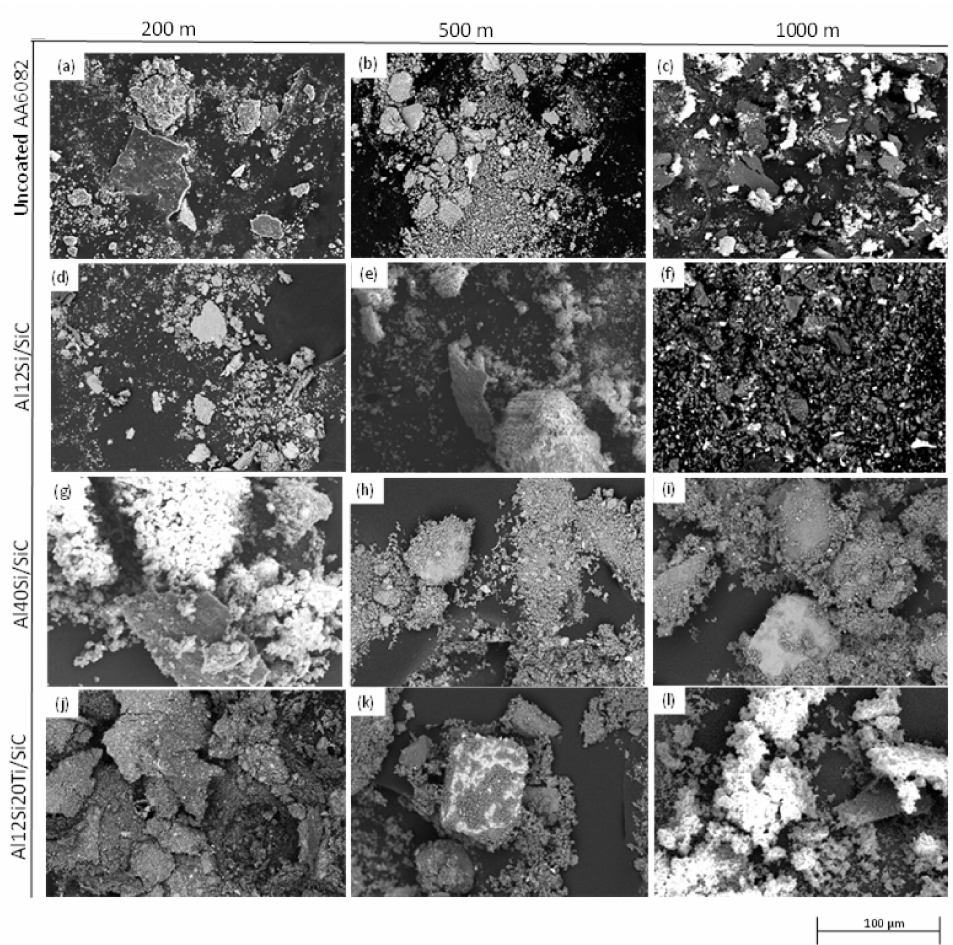
Figure 9. SEM micrographs of the debris obtained in the wear tests of the uncoated AA6082 and the different coatings (Al12Si/SiC, Al40Si/SiC, and Al12Si20Ti/SiC) compared to the sliding distances (200 m, 500 m, and 1000 m); ( a ) uncoated AA6082 debris (200 m); ( b ) uncoated AA6082 debris (500 m); ( c ) uncoated AA6082 debris (1000 m); ( d ) Al12Si/SiC debris (200 m); ( e ) Al12Si/SiC debris (500 m); ( f ) Al12Si/SiC debris (1000 m); ( g ) Al40Si/SiC debris (200 m); ( h ) Al40Si/SiC debris (500 m); ( i ) Al40Si/SiC debris (1000 m); ( j ) Al12Si20Ti/SiC debris (200 m); ( k ) Al12Si20Ti/SiC debris (500 m); and ( l ) Al12Si20Ti/SiC debris (1000